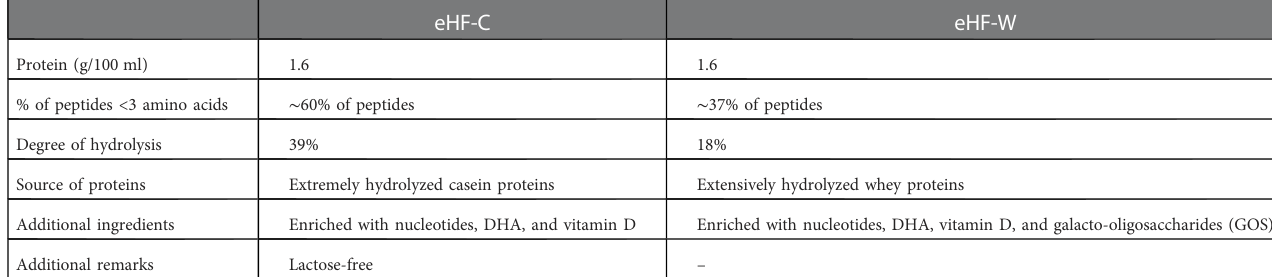
TABLE 1 Product characteristics of the study formulas: formula based on extensively hydrolyzed whey proteins (eHF-C) and formula based on extremely hydrolyzed casein proteins